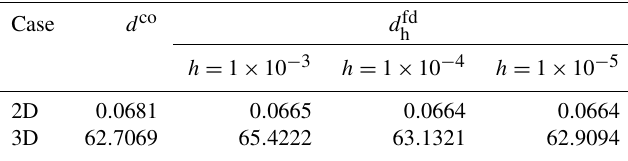
Table 1. Comparison of directional derivatives for 2D and 3D cases between the finite-difference approximation (fd) and our discrete gradient